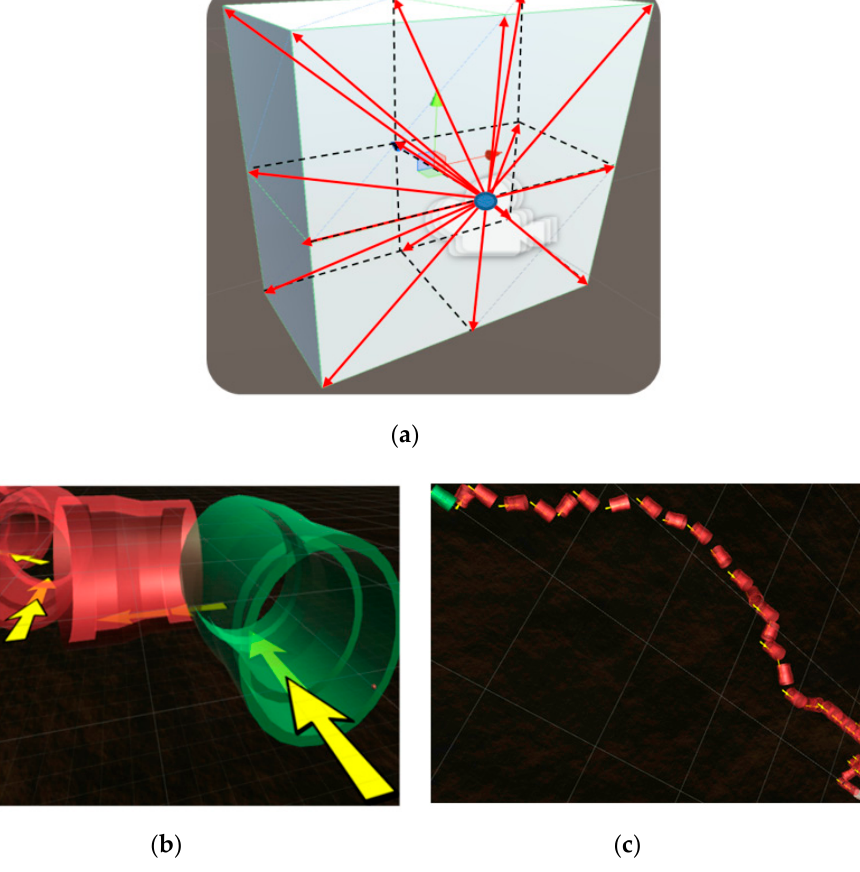
Figure 6. The 17 forward 45 and 90 degree turns possible in the 3D tunneled path ( a ). The first person view of the 3D path ( b ) and the third person view of the overall path of 60 short segments ( c